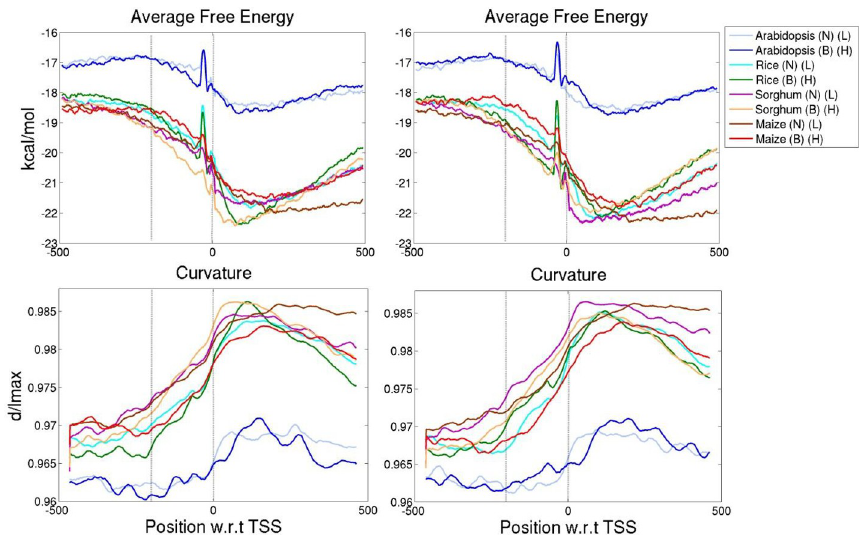
Fig 3. Structural properties of promoters (-500 nucleotides (nt) upstream to +500 nt downstream of TSS) of varying expression breadth (left panel) and level (right panel) are presented for arabidopsis, rice, sorghum and maize. Based on number of tissues in which a gene is expressed as well as average expression values, genes were sorted in increasing order from which top 10% and bottom 10% of genes are included in this analysis. DNA stability, a dinucleotide secondary structure property was represented by AFE (Average free energy) in kcal/mol. Distribution of curvature in the promoter region was calculated by using BMHT dinucleotide parameters. B stands for broadly expressed dataset and N for narrowly expressed genes, whereas H represents highly expressed and L lowly expressed dataset. ‘0’ on x-axis corresponds to the TSS position.